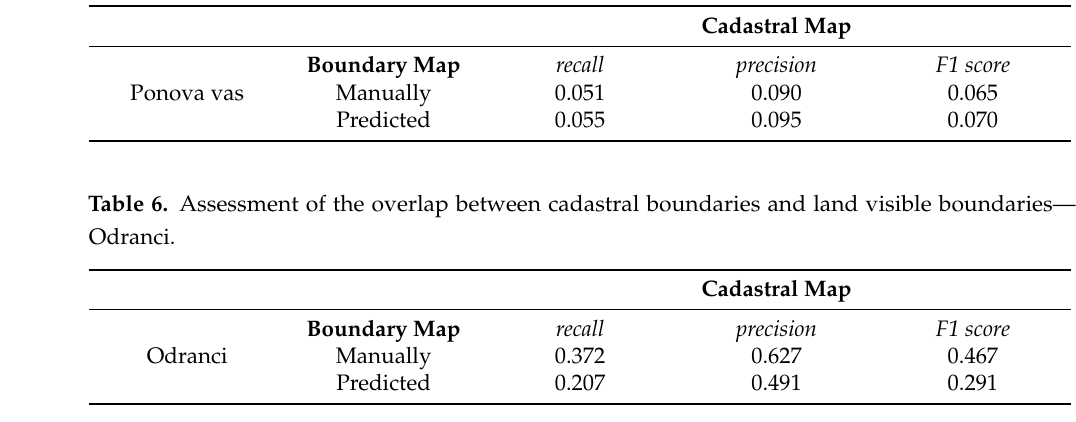
Figure 11. Vectorised predictions overlaid with cadastral boundaries: ( a ) discrepancy map for Ponova vas; ( b ) discrepancy map for Odranci.